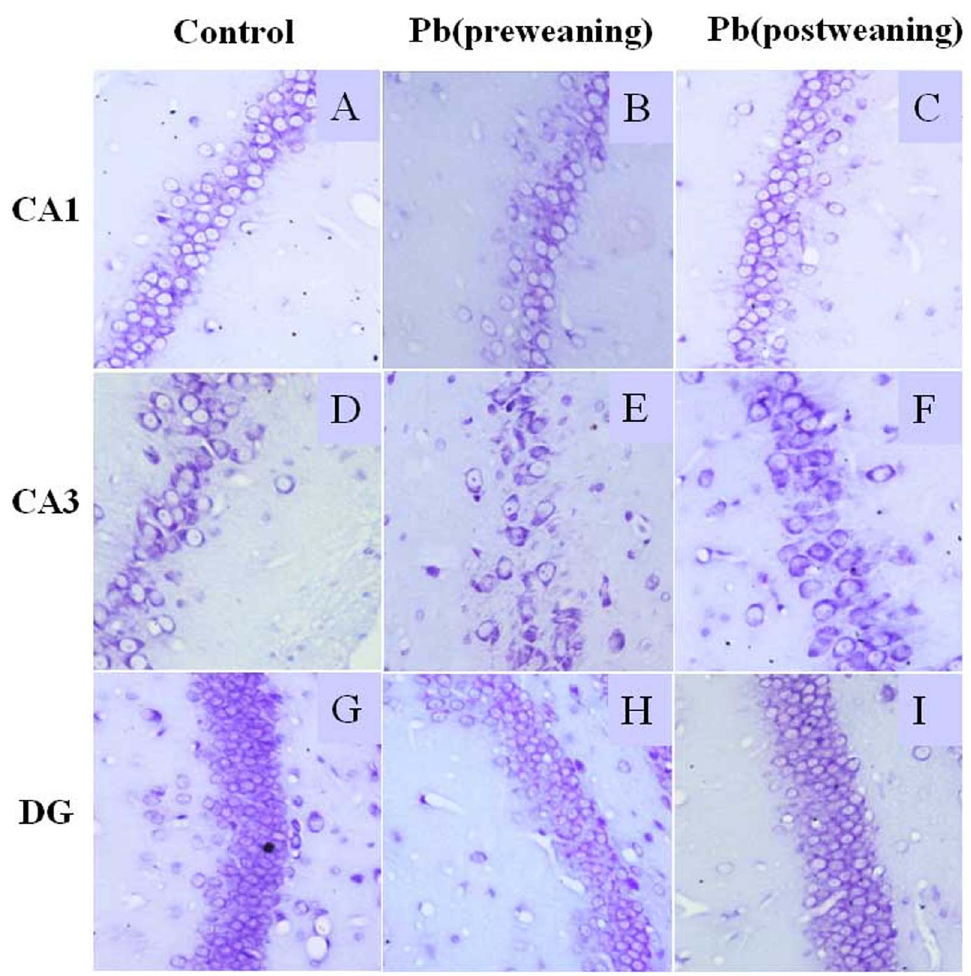
Fig. 2. The pre-weaning but not post-weaning Pb exposure reduces the number of neurons in rat pups at postnatal day 90. The representative Nissl staining of neurons nissl bodies in hippocampal subregions (DG, CA1 and CA3) of rat pups from control (A, D, and G), Pb (pre-weaning) (B, E, and H) and Pb (post-weaning) group (C, F, and I). The representative photomicrograph of each region of hippocampus by Nissl staining in each group at 400x magnification. The number of Nissl staining positive neurons was counted as described in Materials and Methods, and calculated as shown in Table 3. The number of neurons in pre-weaning Pb exposure groups was less than that in control group ( p ,